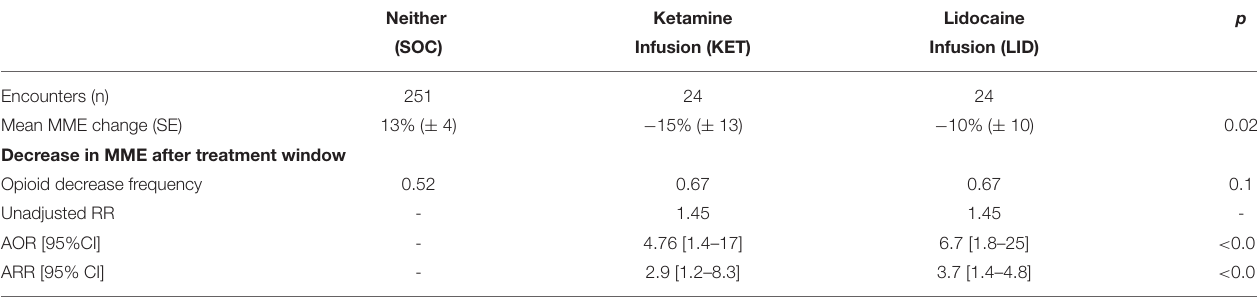
TABLE 5 | Results of intergroup and conditional logistic regression analysis.